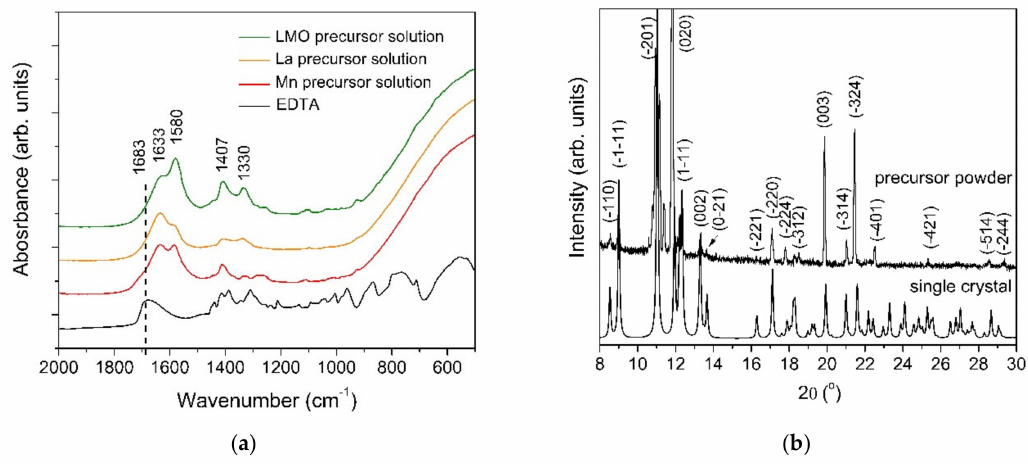
Figure 2. ( a ) FT-IR spectra and ( b ) XRD di ff raction pattern of both the precursor powder and single crystal